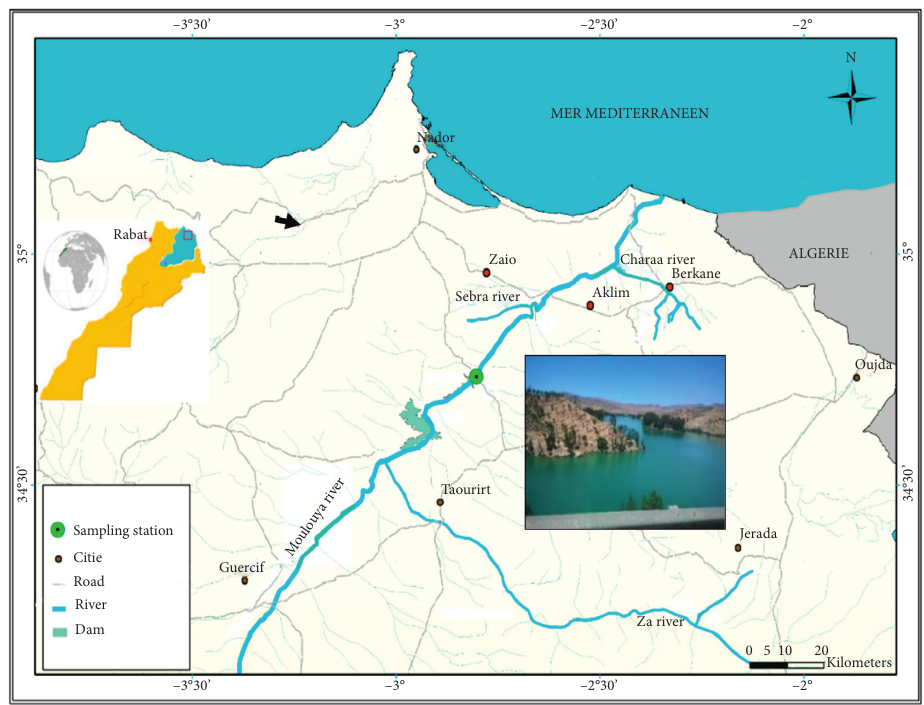
Figure 1: Localization map of the study area and location of sampling station Table 1: The wavelength, limit of detection (LD), limit of quantification (LQ), standard calibration concentration, and correlation coefficient ( r ) for trace metal determination.